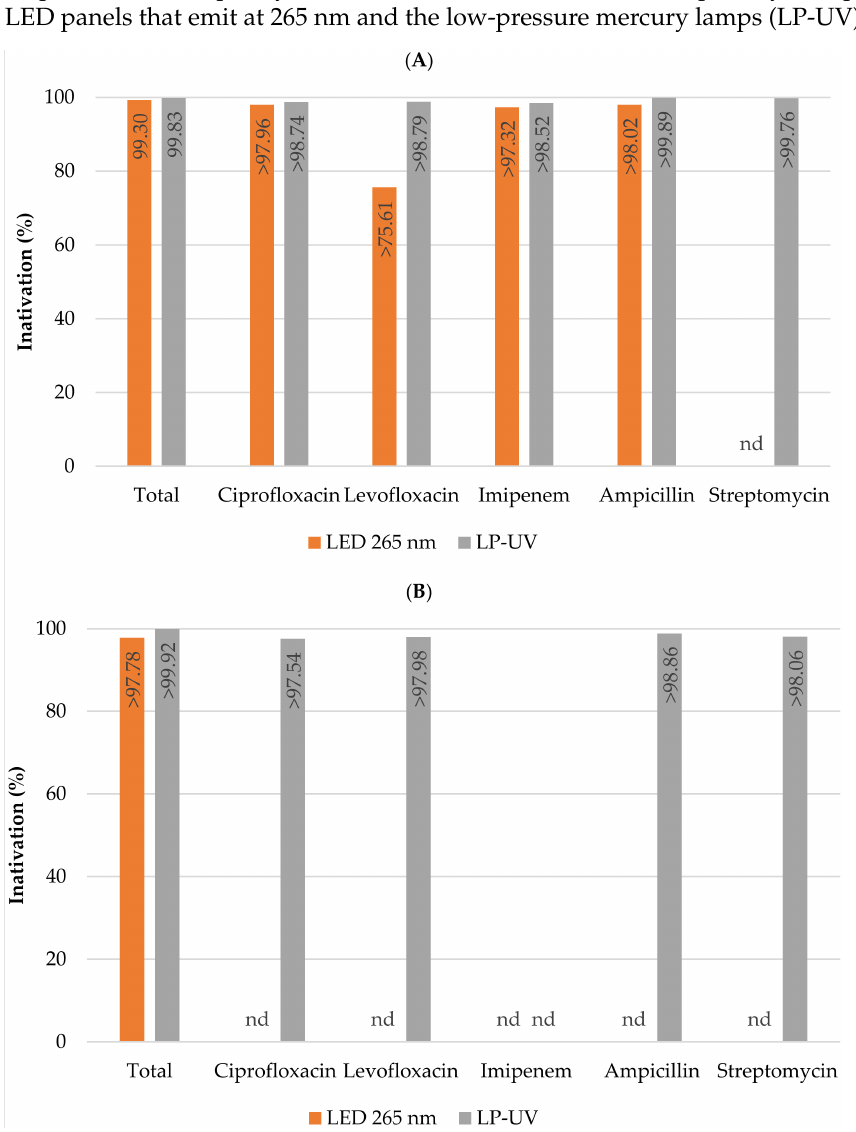
Figure 4. Percentage inactivation of total coliforms and total coliforms resistant to various